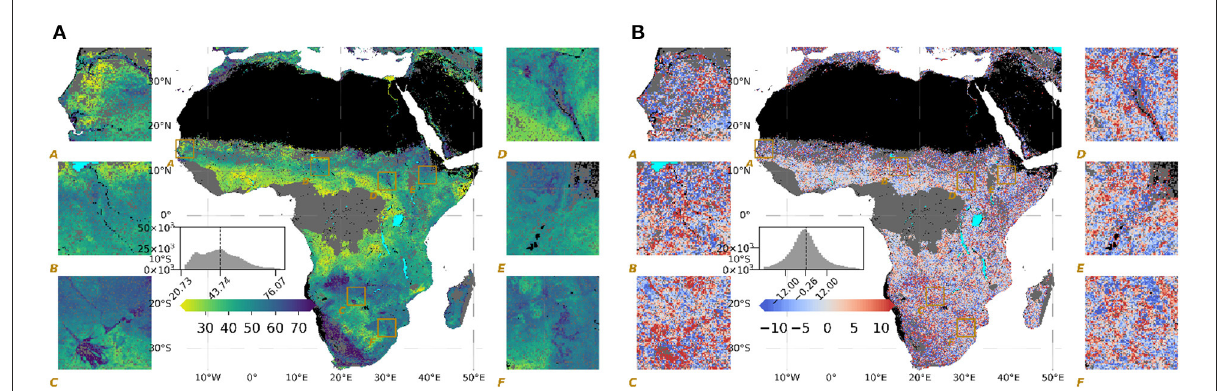
FIGURE1 Maps of (A) model output ( λ m ), in days, where larger values of λ (blue) indicate slower decay (B) residual of the model ( λ − λ m ), in days, where positive values (red) indicate underestimation. Histograms of the mapped values for the entire domain are given in the main panels of all the maps with a dashed line indicating the mean values of the domain, as well as six insets to show local variability.